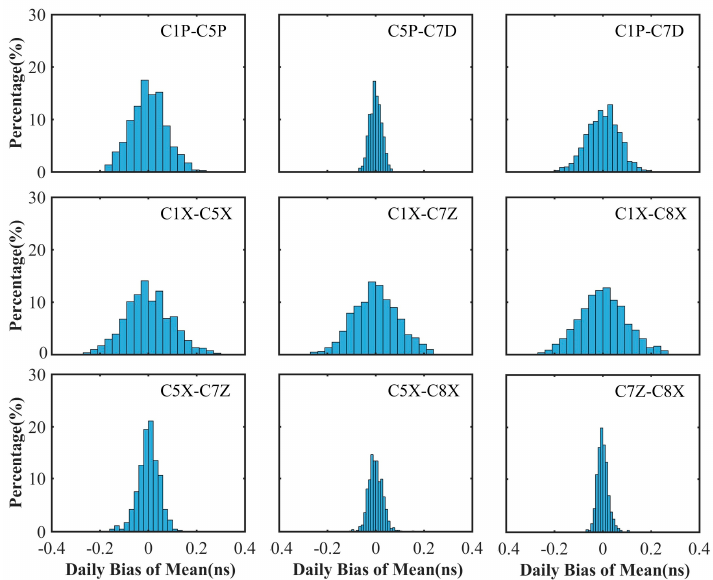
Figure 6. Distribution of deviations between nine DCB types of BDS-3 satellites and the corresponding mean values.